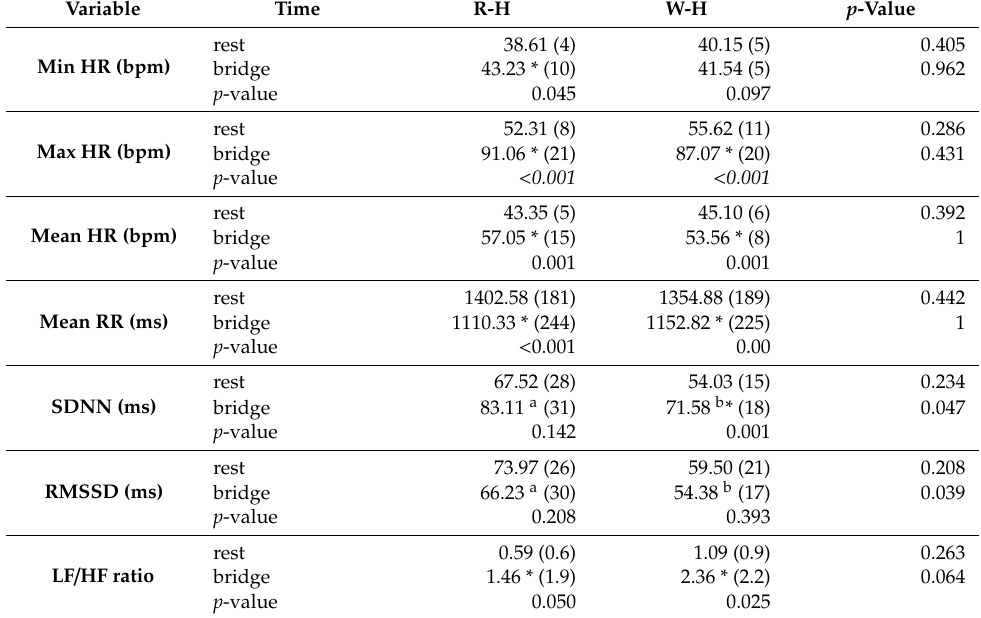
* Indicates significant di ff erences ( p < 0.05) within groups (R-H and W-H) between sampling periods (rest and bridge test) for each variable. Di ff erent letters (a, b) indicate significant di ff erences ( p < 0.05) between groups (R-H and W-H) within a same sampling period (rest or bridge test) for each variable. R-H, rodeo horse; W-H, working horse; HR, heart rate; RR, R wave to R wave interval; SDNN, standard deviations of the RR intervals; RMSSD, root mean square of successive RR di ff erences; LF / HF ratio, low frequency band to high frequency band